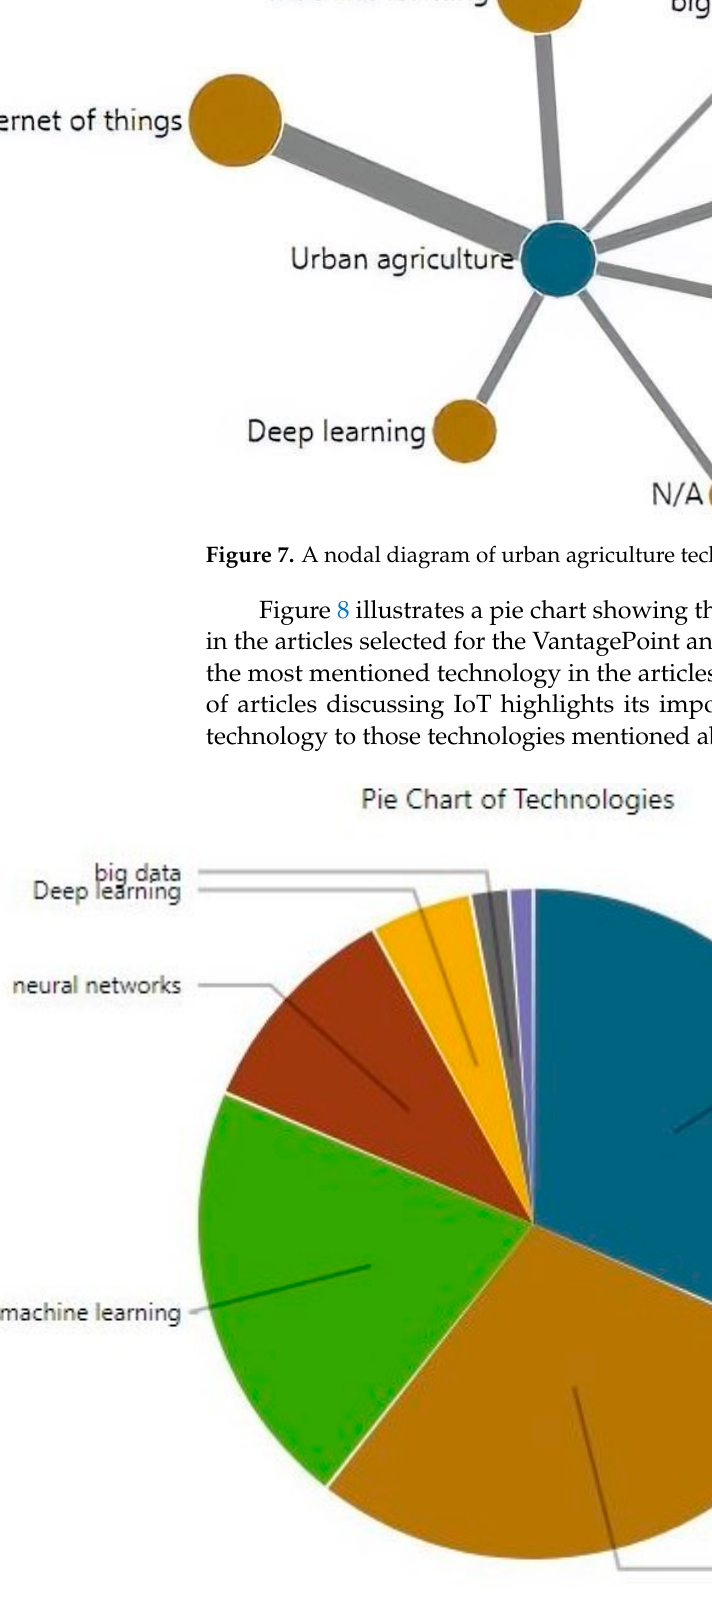
Figure 8. A pie chart of urban agriculture technologies. Obtained using VantagePoint.